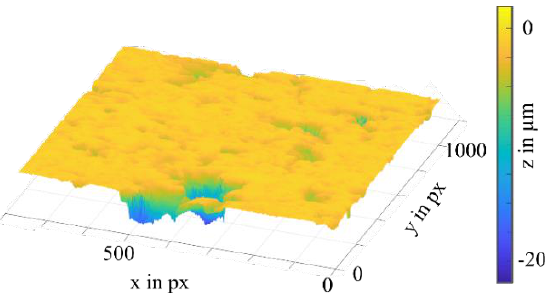
Fig. 1. 2.5D height image of a thermal sprayed Al 2 O 3 ceramic.